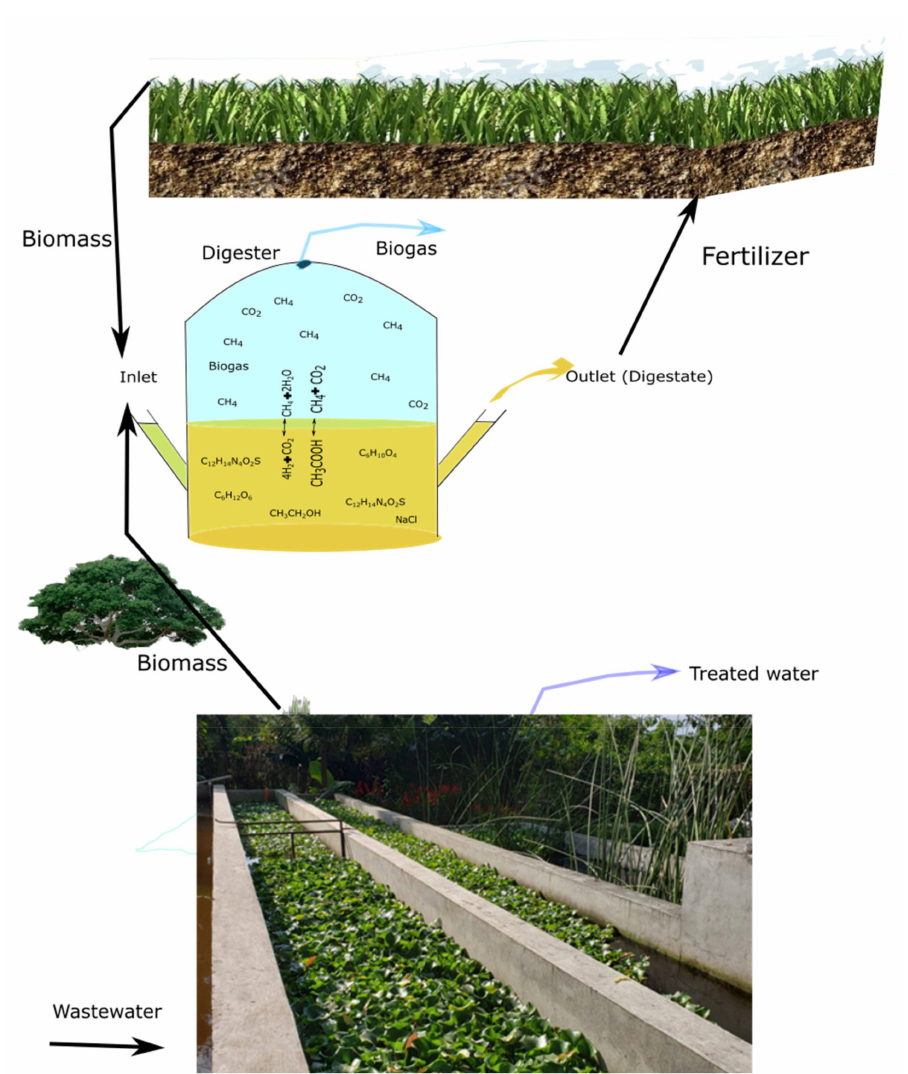
Figure 2. Biofiltration using a constructed wetland and subsequent biogas production